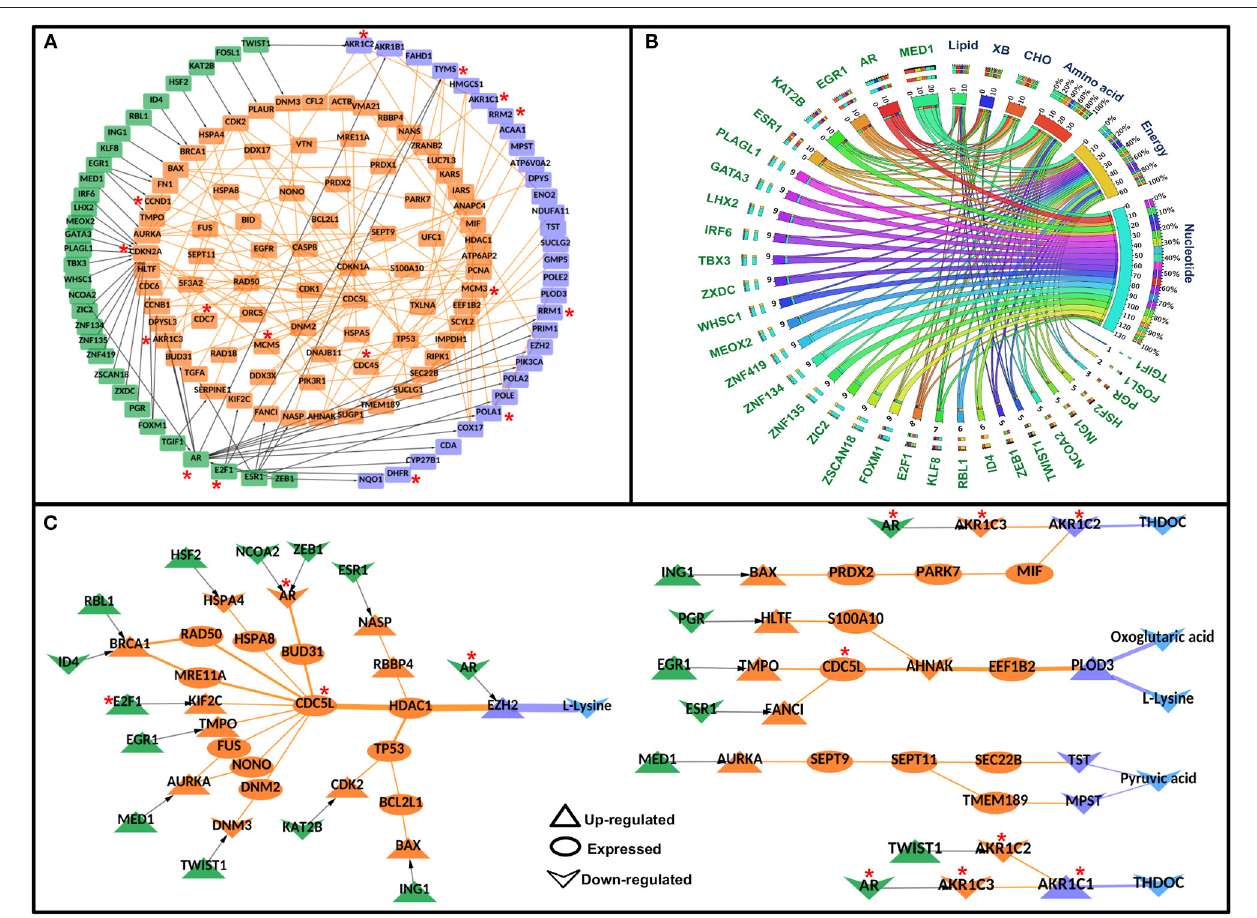
FIGURE 4 | Significant Transcription factor-metabolic pathway interconnecting paths/network in cervical cancer. (A) represents a significant transcription factor metabolic interaction network, (B) shows the transcription factor to metabolic pathways interconnectivity, and (C) shows the significant transcription factor to metabolic paths regulating metabolites in cervical cancer. Terminal transcription factors and metabolic enzymes are colored green and blue. Protein-protein interactors are colored in orange. Gene regulatory edges are represented as black arrows and protein-protein interactions are represented by orange edges. Nodes with an asterisk (*) are key or effector nodes in the significant